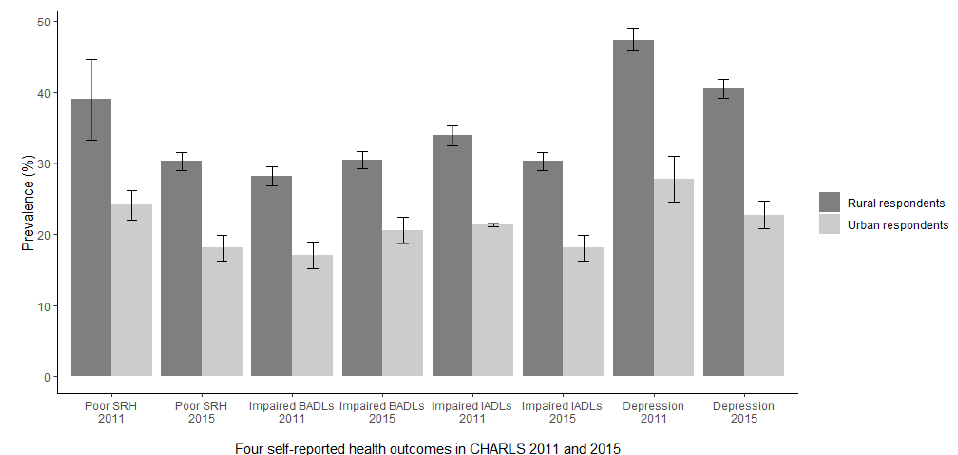
Figure 2. Prevalence (%) and 95% confidence interval (error bars) of poor Self-Rated Health (SRH), impaired Basic Activities of Daily Living (BADLs), impaired Instrumental Activities of Daily Liv- ing (IADLs), and self-reported depression among rural and urban respondents, CHARLS 2011 ( n = 6048) and CHARLS 2015 ( n = 7396).